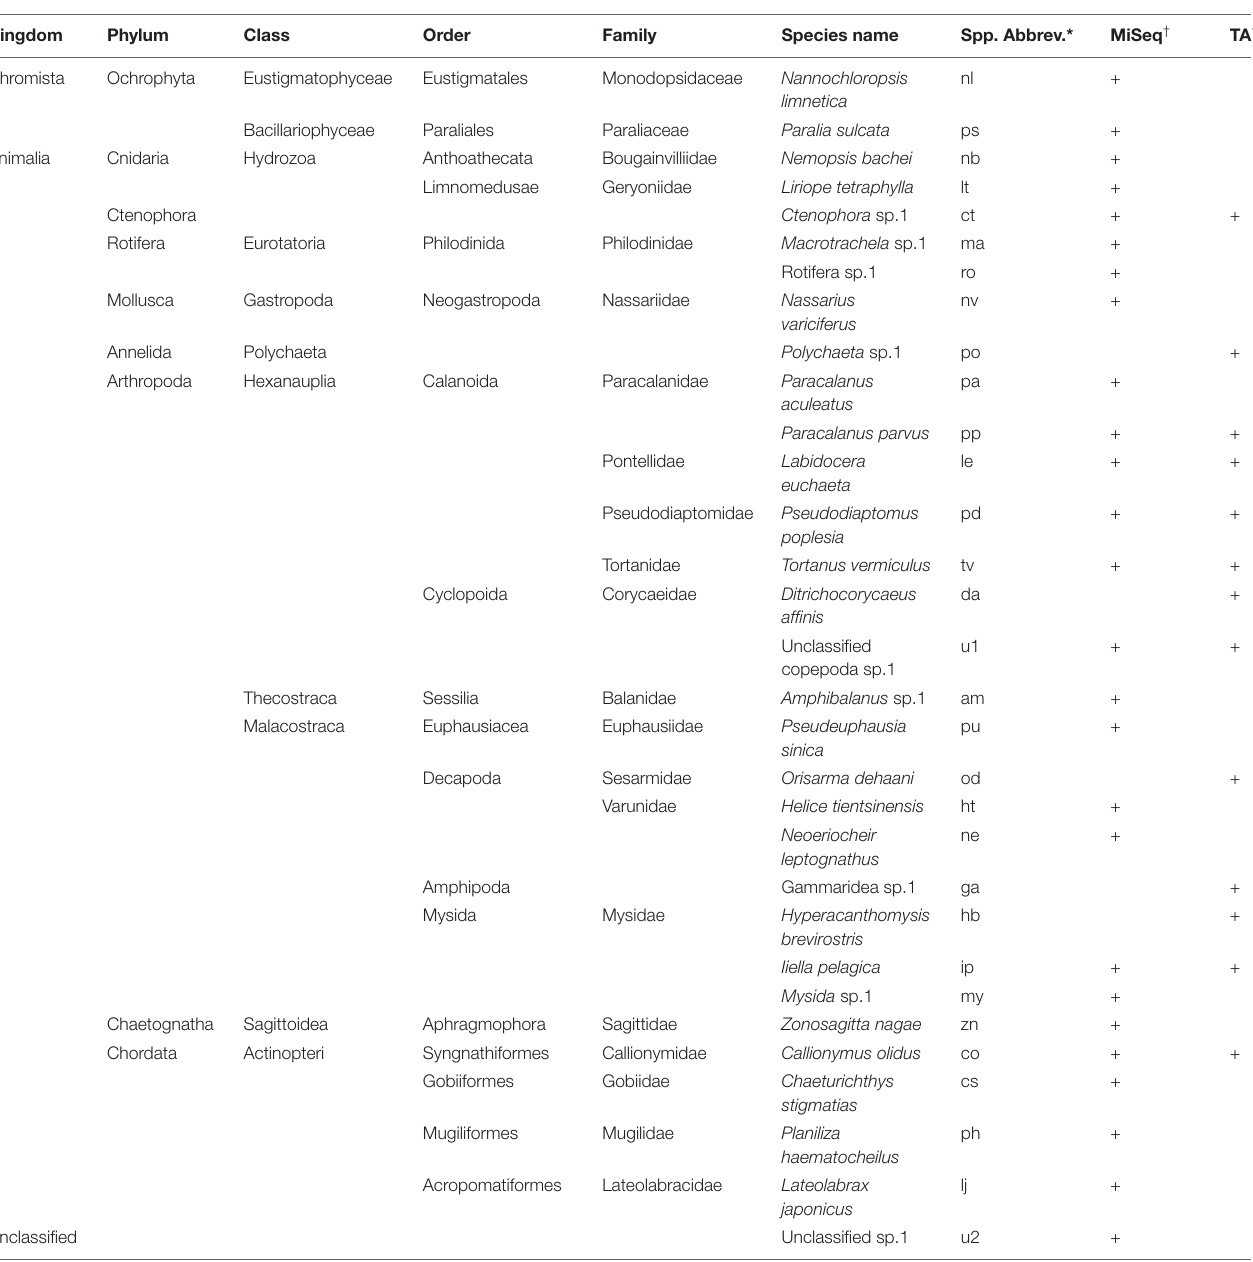
TABLE 2 | Prey species of post-larval and juvenile L .